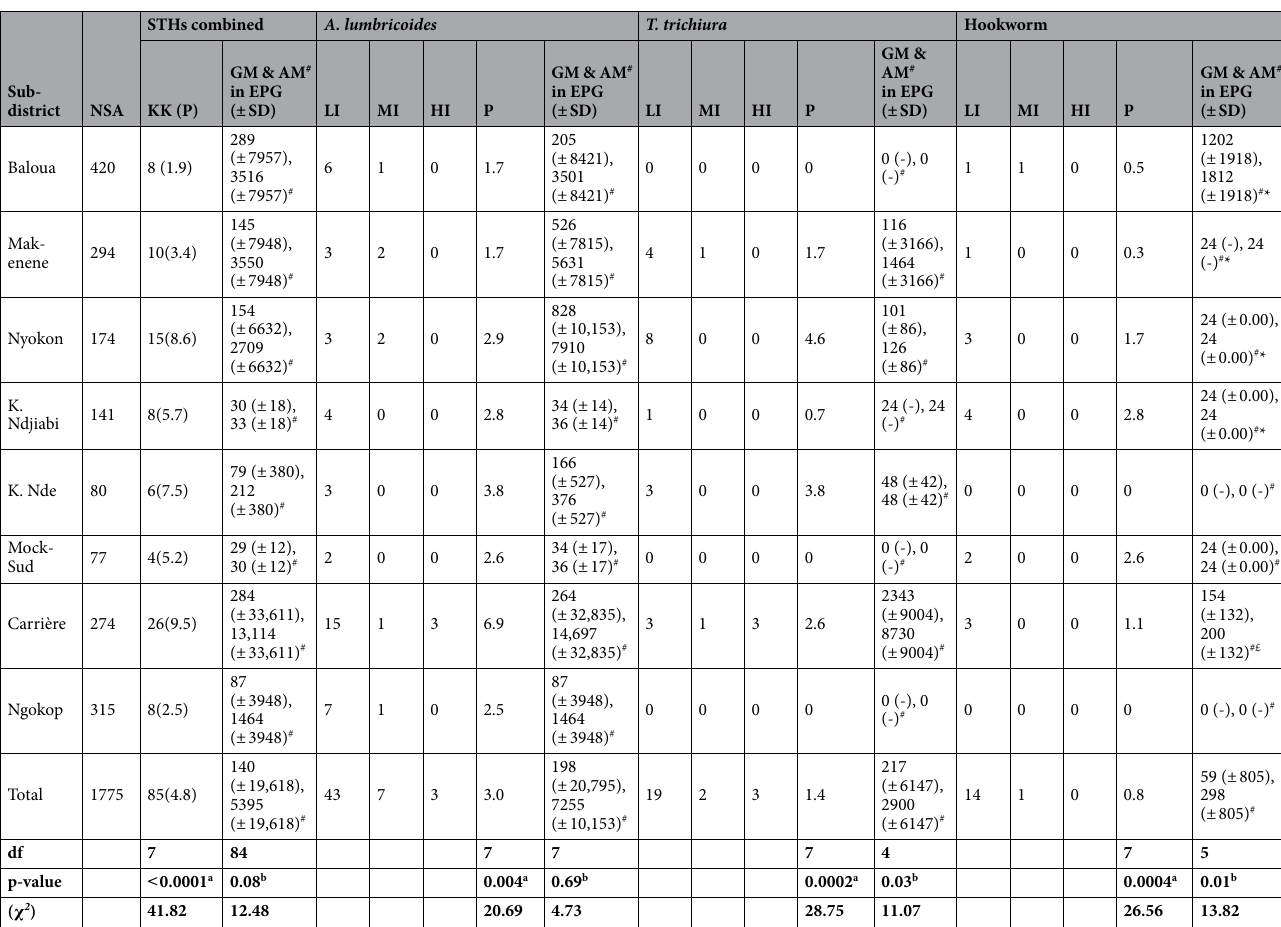
Table 4. Prevalence and infection intensities of soil-transmitted helminth species according to sub-districts. STHs soil transmitted helminths; A. lumbricoides , Ascaris lumbricoides ; T. trichiura , Trichuris trichuria ;